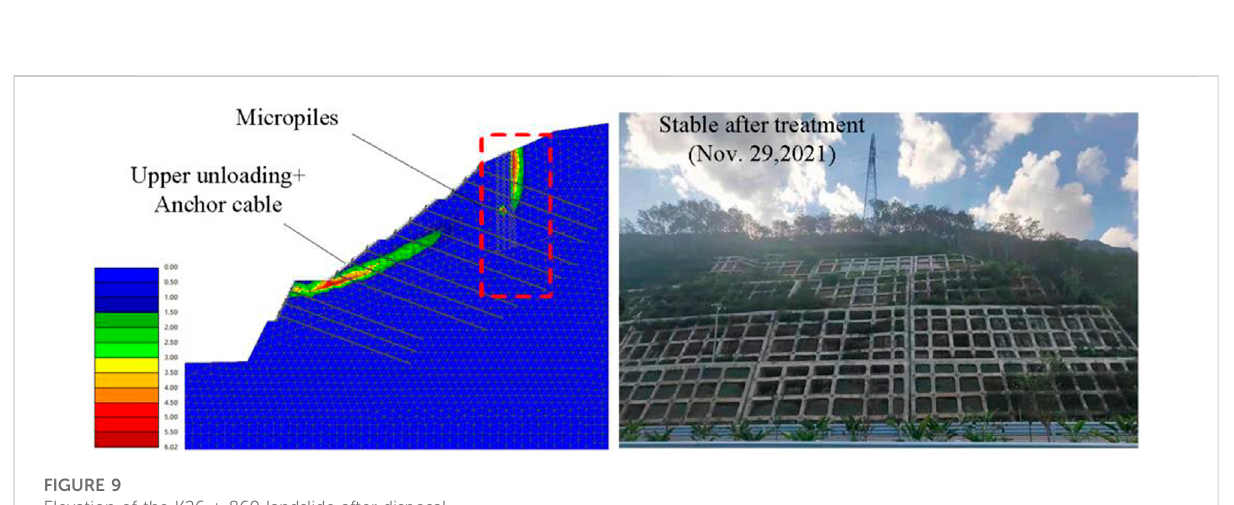
Elevation of the K26 + 860 landslide after